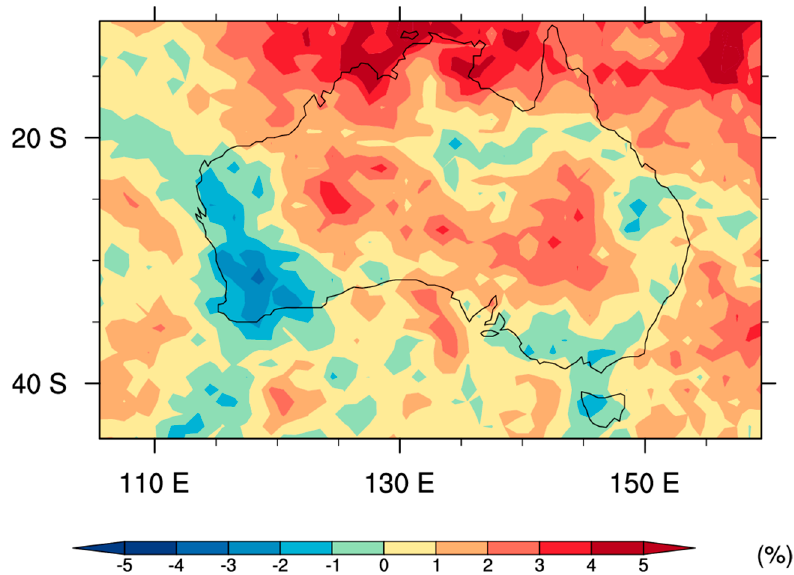
Figure 5. Change in the average cloud frequency of HIRS high thick (CTP < 440 hPa; 0.5 < ε < 0.95) between two different eight − year periods for the Australian region (10° S – 45° S, 105° E – 160° E). Difference = (1994 − 2001) minus (1985 − 1992).